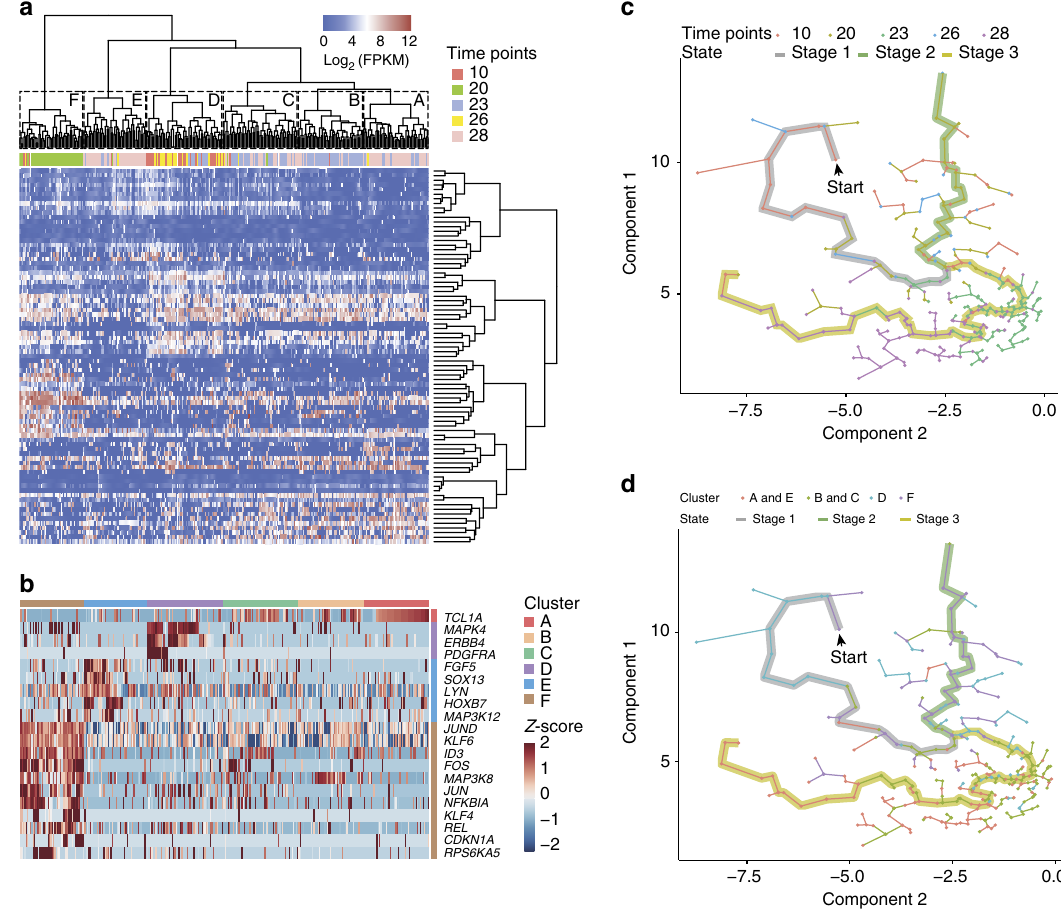
Figure 4 | Dynamic changes revealed by single-cell RNA-seq analysis. ( a ) Hierarchical clustering of single-cell RNA-seq data from 300 single cells of five time points. Each column represents a single cell, and each row represents a gene. ( b ) The Z -scores of cells from different time points in different clusters. ( c , d ) Cell expression profiles in pseudo-temporal ordering. Points represent single cells. Lines connecting points represent the edges of the minimum spanning tree by Monocle program. The thick lines represent the main path of the pseudo-temporal